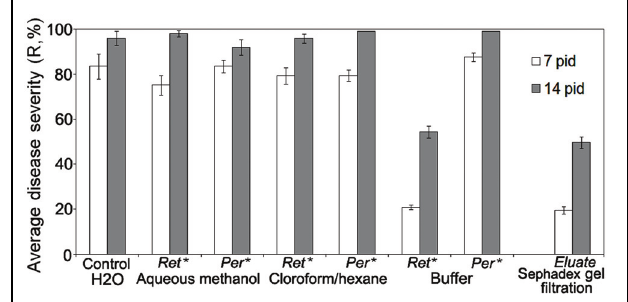
FIGURE 1 | Comparison of specific anti-wilt activity of different extracts from biomass of biocontrol Fusarium oxysporum strain CS-20 separated by ultrafiltration and gel filtration on Sephadex G-50. ∗ Ret.-retentate contains solutes greater than 5 kDa (are considered as high-molecular weight metabolites); Rer. -permeate contains low-molecular weight solutes. Water-solubilized preparations of freeze-dried extracts passed through 5 kDa-cut-off membranes were tested. Retentates and permeates were adjusted to equal volumes. Means of three independent experiments, with three replications per treatment in each ones, are presented. Bars represent SE. Activity in the permeates from samples extracted with the buffer were tested against H 2 O amended with salts, which remained in this permeate after isolation procedure used (see Materials and Methods, Ultrafiltration). Eluate means an active fraction that was eluted from Sephadex G-50 with double distilled water (see section ‘Materials and Methods’).